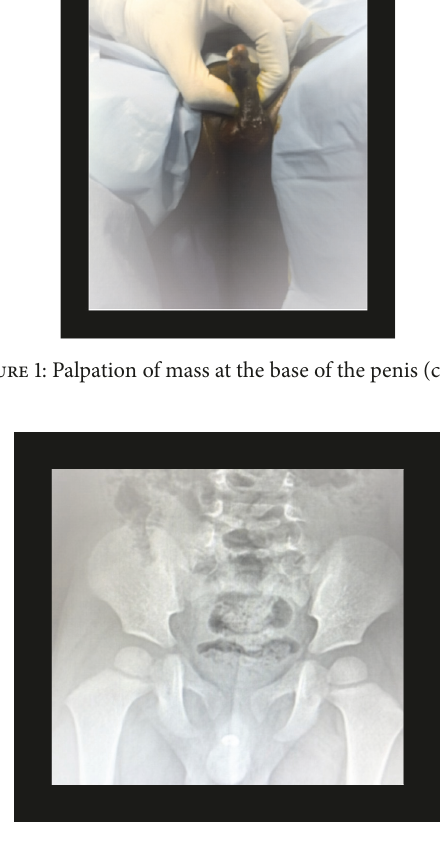
revealed E. coli sensitive to ceftriaxone. Blood count, urea, and creatinine were normal. A suprapubic cystostomy was performed at